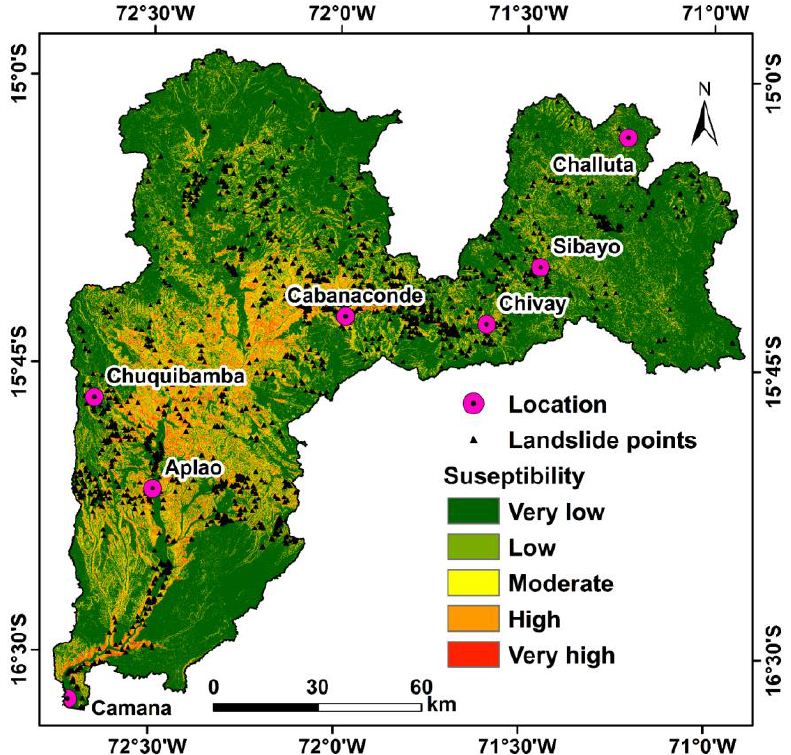
Figure 13. Landslide susceptibility map of the study area derived from the ANN + RTF using the top 5 LIFs.